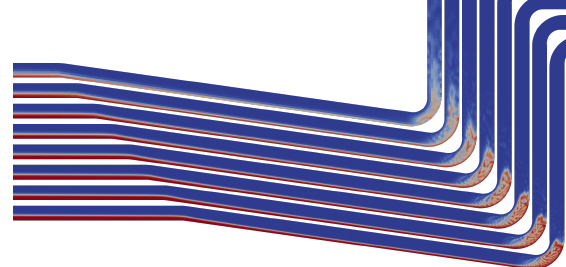
Figure 6. Longitudinal cut at y = 0 m. Coarsest mesh is at upper left and finest at lower